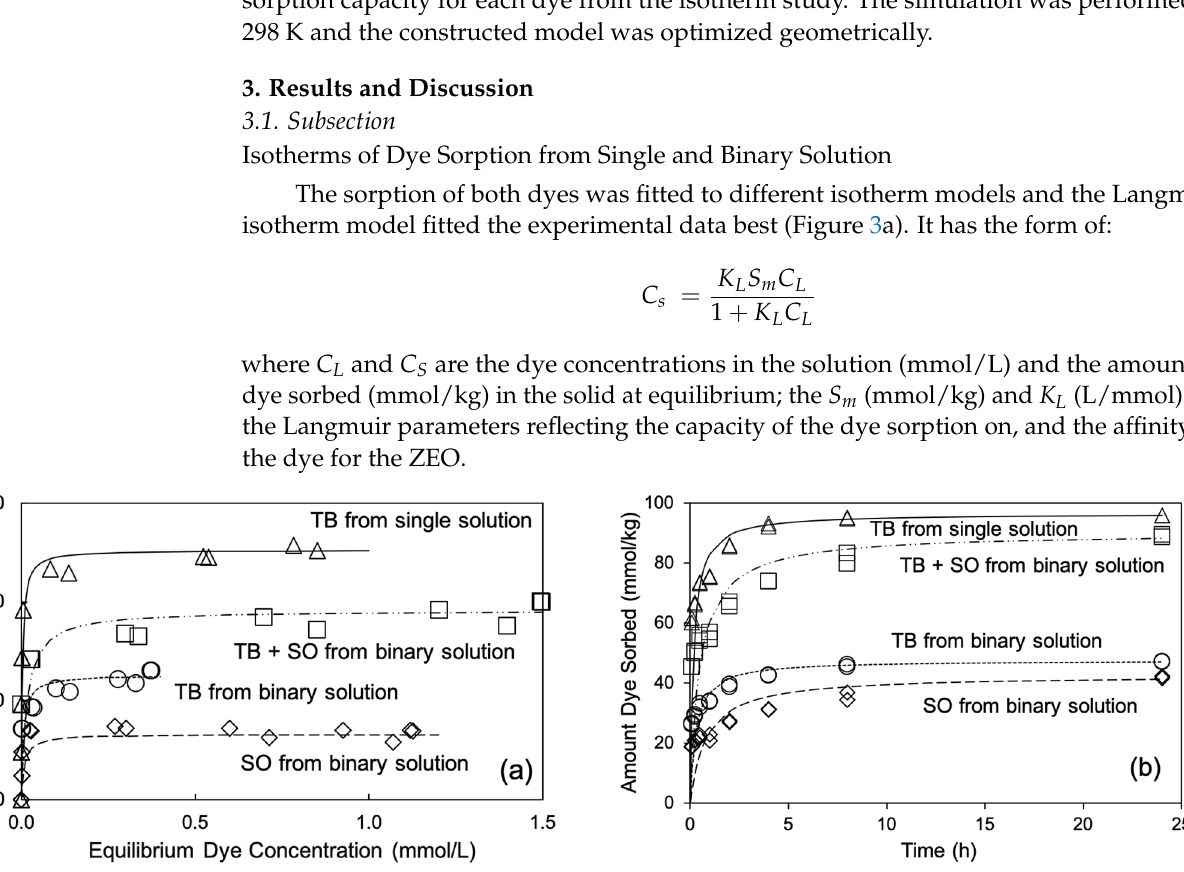
Figure 3. Isotherm ( a ) and kinetic study of TB and SO sorption form single and binary solutions on ZEO. The lines are Langmuir ( a ) and pseudo-second order ( b ) fit to the experimental data.